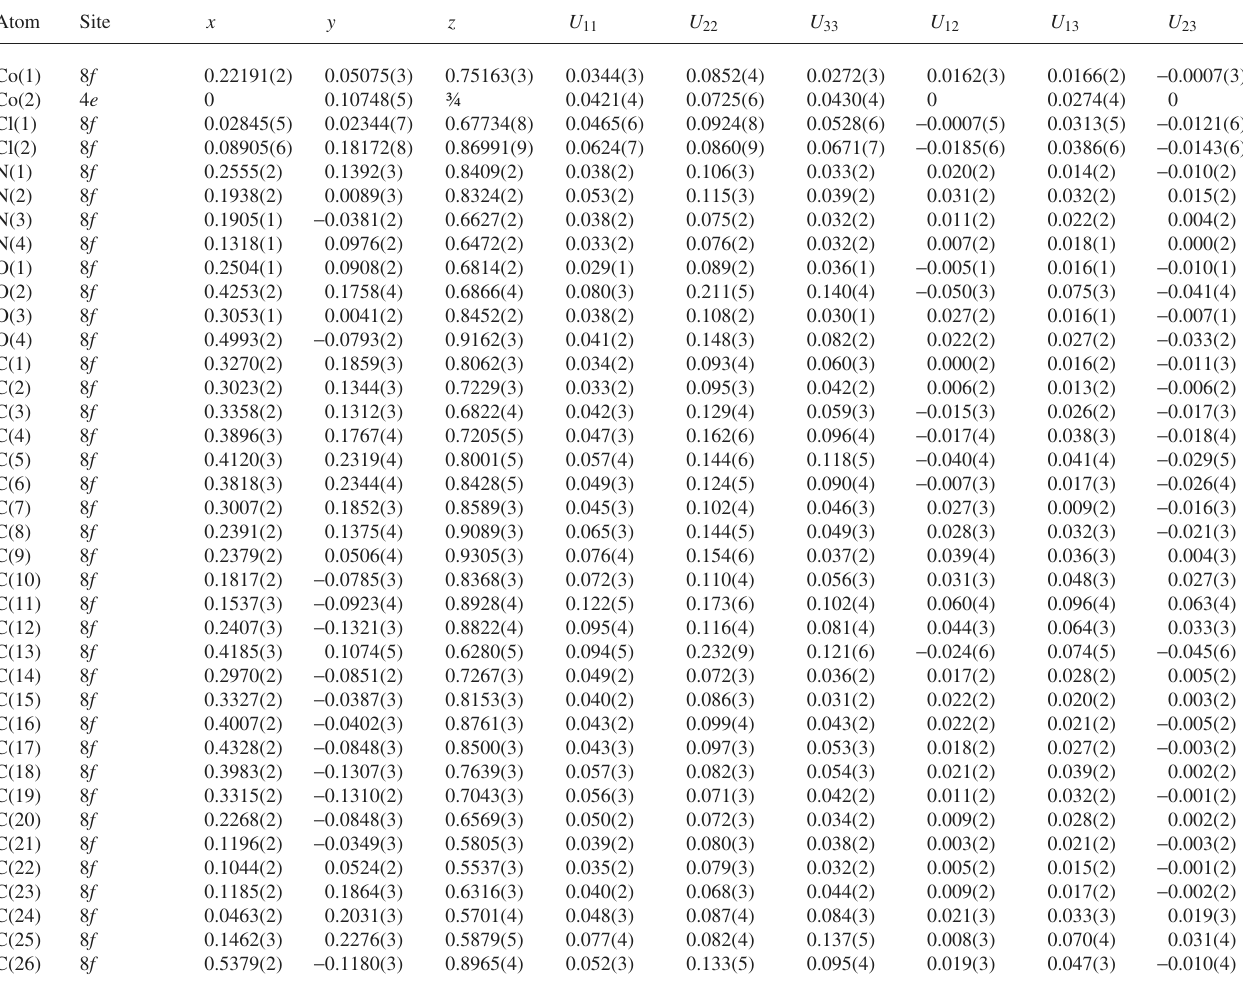
Table 3. Atomic coordinates and displacement parameters (in Å 2 ) .